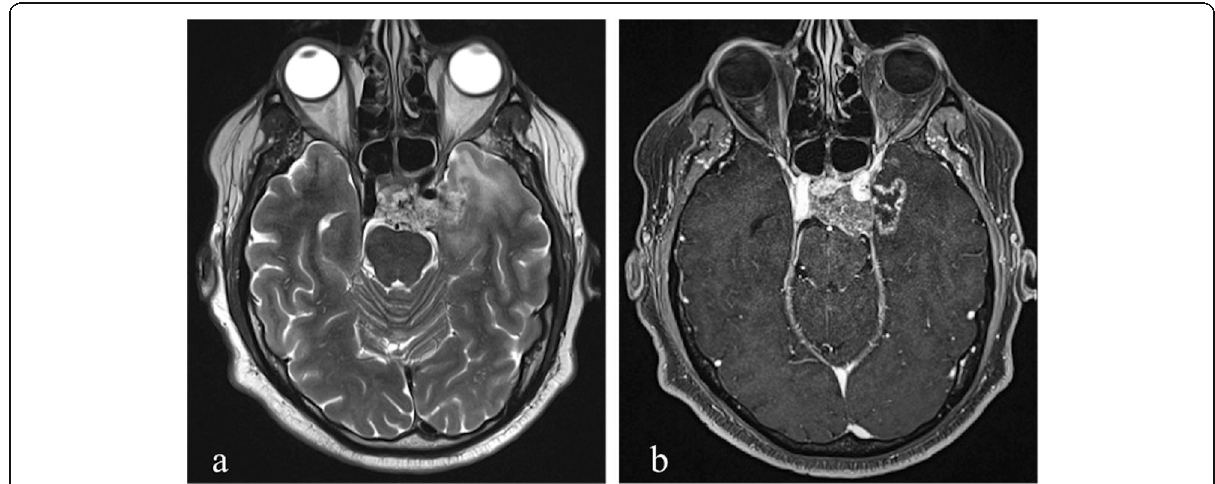
Fig. 3 MRI performed 14 months after 74 Gy Proton-beam therapy in a patient who previously underwent subtotal surgical resection of clival chordoma. Axial T2-weighted image ( a ) shows hyperintensity involving subcortical white matter in left polar temporal region right adjacent to clival structures. Axial post-contrast T1-weighted image ( b ) reveals a focal non-enhancing portion related to necrotic tissue with a peripheral